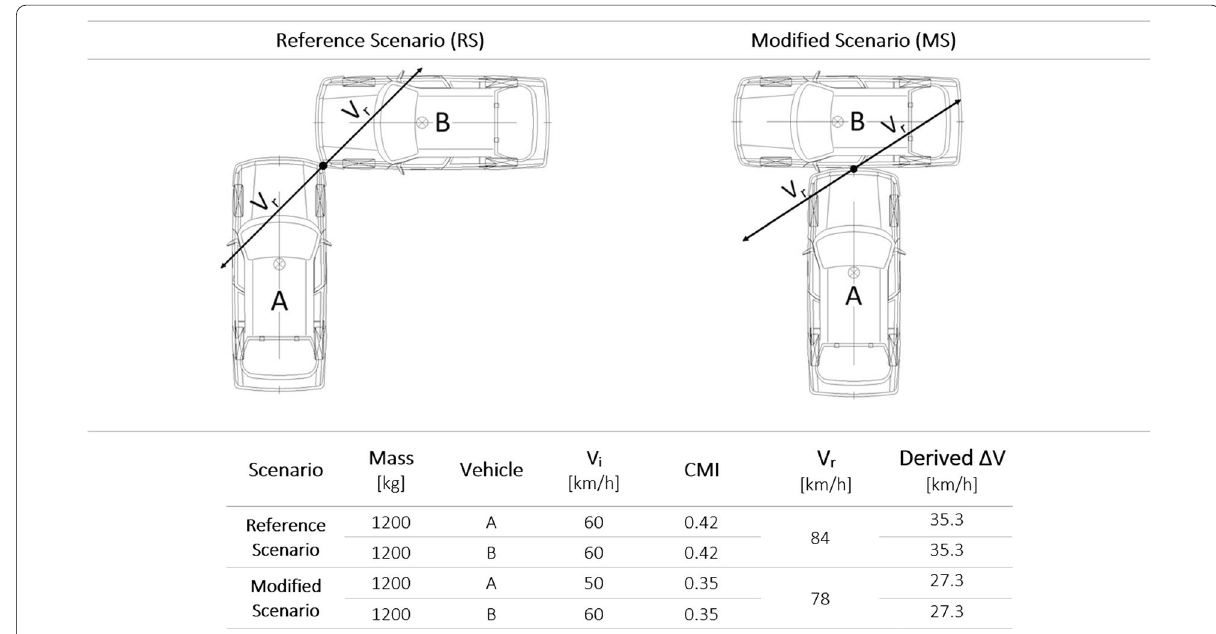
Fig. 5 Visualization and data for the “Collision with another vehicle that is turning into or crossing a road at an intersection”-type scenario